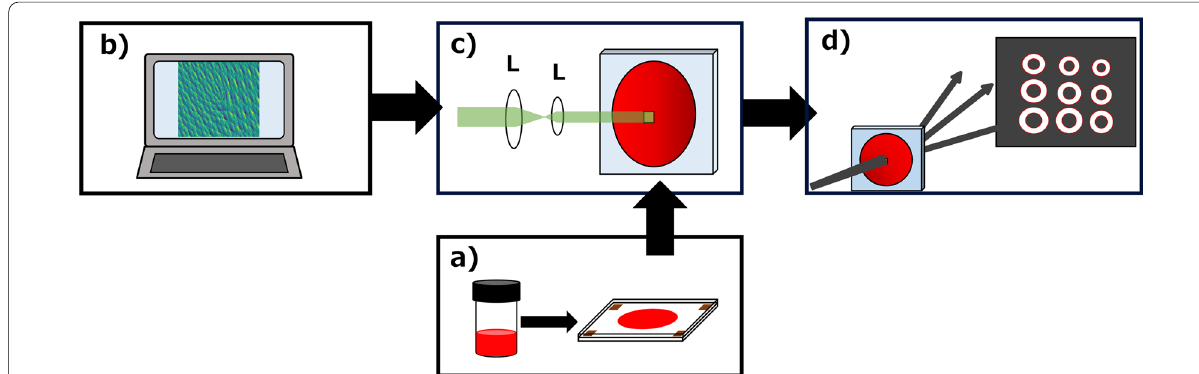
Fig. 1 Schematic showing the steps involved in devising the optical vortex array generator, a synthesis of hologram material (Azocarbazole polymer), b digital computation of hologram pattern capable of reconstructing the vortex array, c optical transfer of the computed pattern onto the synthesized material (digital hologram recording) and d reconstruction of optical vortex array by illuminating the recorded digital hologram using a Gaussian